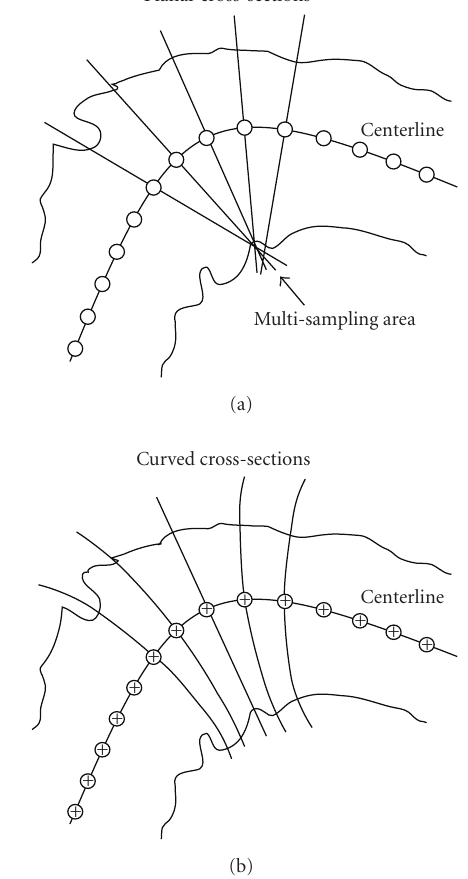
Figure 2: Cross-sections generated for a tubular structure with respect to its centerline. (a) Possible intersections of planar cross- sections perpendicular to the centerline, which may lead to redundant or little sampling of the surface, and (b) curved cross- sections based on an electrical field, in which positive charges are distributed along the